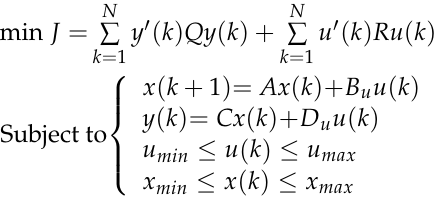
Figure 6. Model predictive control (MPC) control procedure.